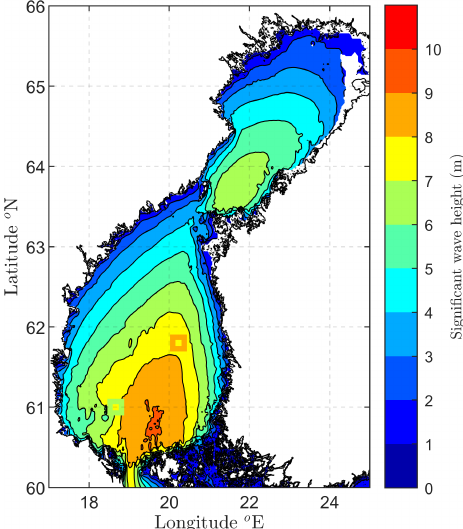
Figure 6. The maximum significant wave height for the Jan- uary 2019 storm from the calibrated wave hindcast. The maxi- mum measured significant wave heights at the Bothnian Sea and Finngrundet wave buoys are shown by overlaid